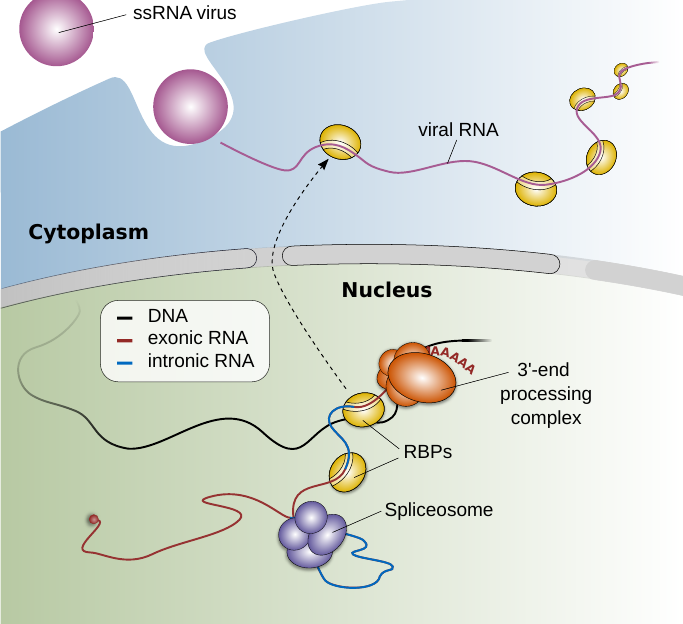
Figure 4. Virus–host factor interactions impact the gene expression of the host cell. Single-stranded RNA (ssRNA) viruses enter the cell and release their RNA genomes into the cytoplasm of the host cell. Viral RNAs can contain binding sequences for host RNA binding proteins (RBPs). The binding of host RBPs to the viral RNA can have proviral or antiviral effects. The sequestration of RBPs by cytoplasmic viral RNA was reported to cause changes in host cell RNA splicing, polyadenylation, and stability